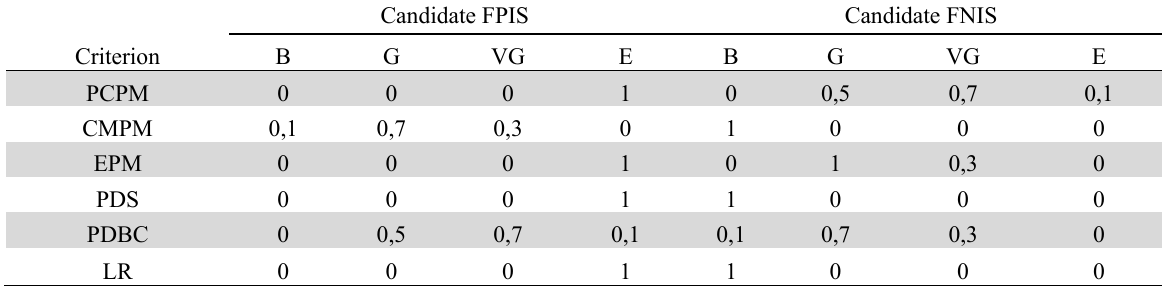
Candidate evaluation on Behavioral TOPSIS